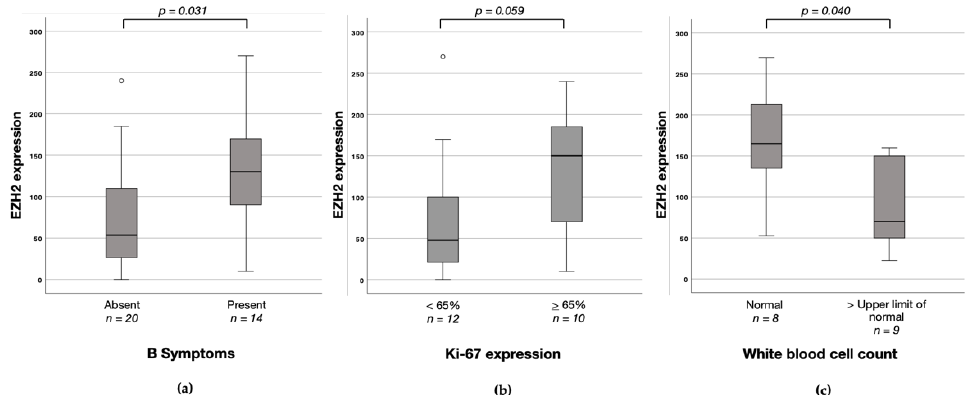
Figure 5. EZH2 protein expression (H-score) according to clinicopathological characteristics in nodal T-cell non-Hodgkin’s lymphomas (T-NHL). ( a ) Corresponding boxplot of EZH2 protein expression depending on the presence of B symptoms. ( b ) Corresponding boxplot of EZH2 protein expression depending on Ki-67 expression. ( c ) Corresponding boxplot of EZH2 protein expression depending on white blood cell count.